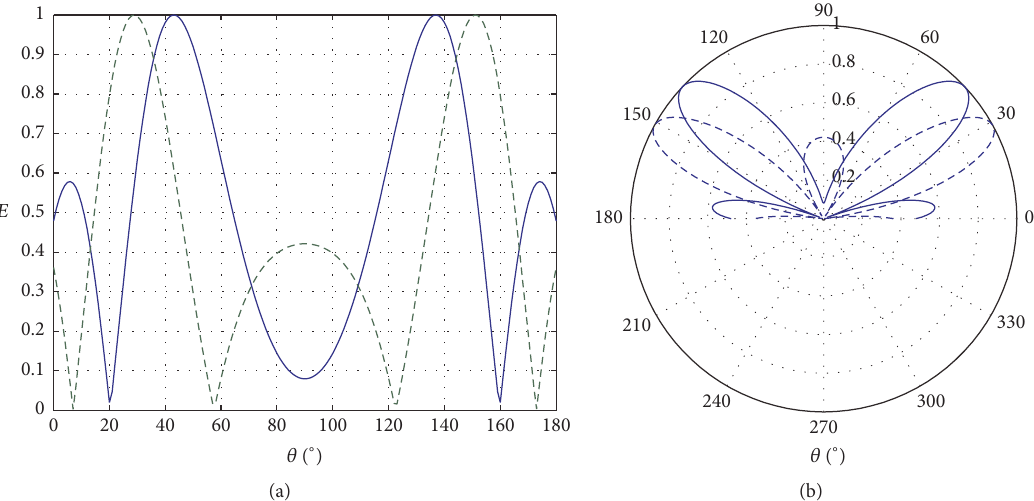
Figure 8: Pattern of 16-element circular array. (a) Normalized Cartesian coordinates. (b) Normalized polar diagram. ( 𝜙 = 45 ∘ , 𝜙 0 = 30 ∘ , ∘ (---)/45 ∘ (—)). 𝑅/𝜆 = 1: 1, and 𝜃 0 = 30